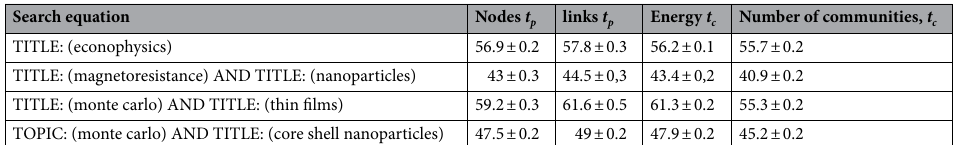
Search equation Nodes t p links t